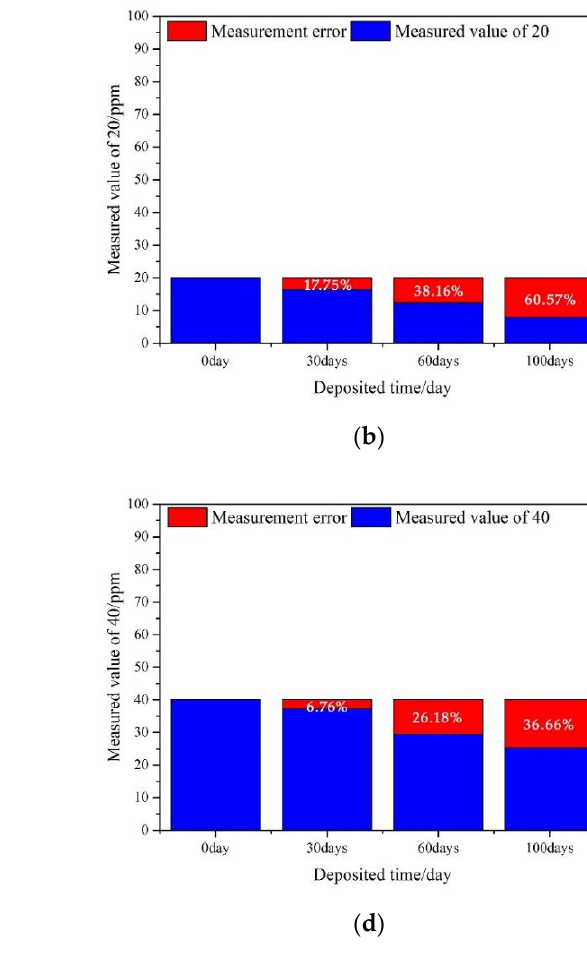
Figure 9. Sensor measurements at different concentrations of SO 2 gas and different fly ash deposi- tion times.